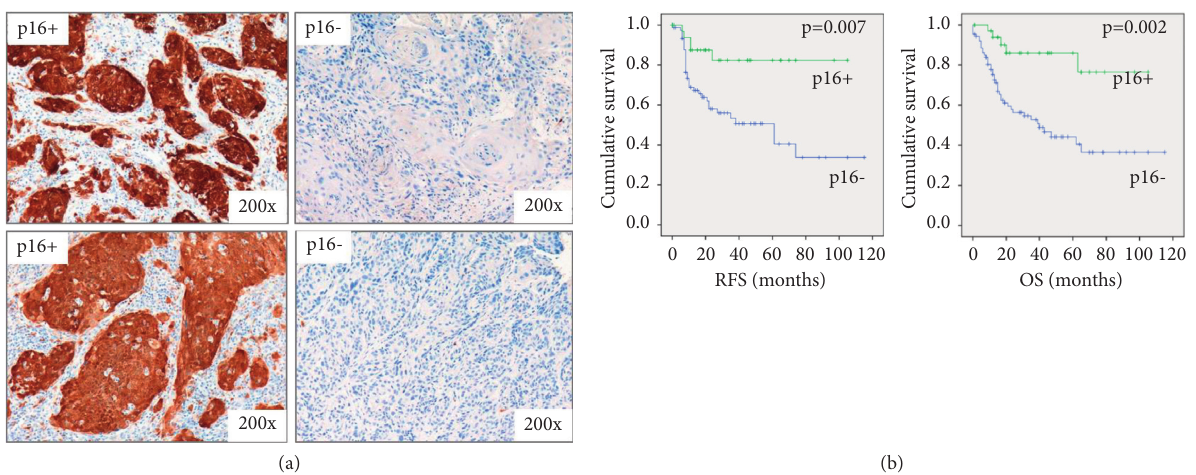
Figure 1: Evaluation of the p16 level in oropharyngeal tumors and association with survivals. (a) Assessment of p16 positivity in OSCC patients by immunohistochemistry. High p16 immunostaining corresponding to a transcriptionally active HPV infection (p16+). (b) Evaluation of RFS and OS regarding p16 status. Patients with p16+ tumors ( n � 36) have a significant longer RFS (HR: 3.6, 95% CI: 1.4–9.3) and OS (HR: 4.3, 95% CI: 1.7–10.9) compared to p16 − tumors ( n � 88).